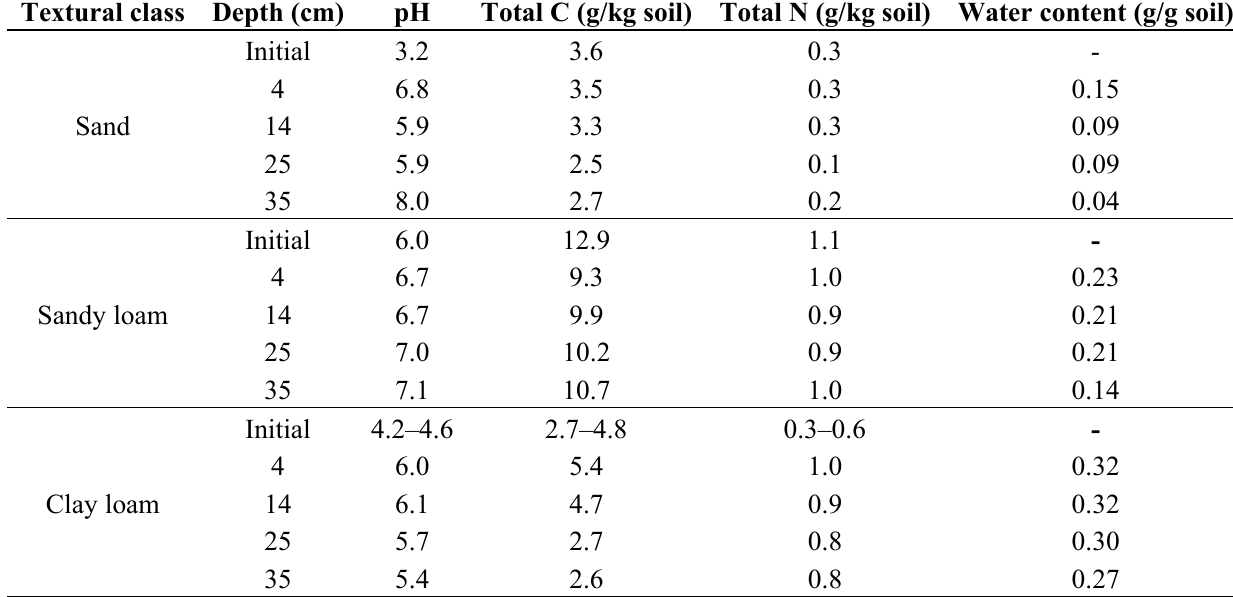
Table 2. Soil properties prior to septic tank effluent addition (initial), and after biomat formation. Textural